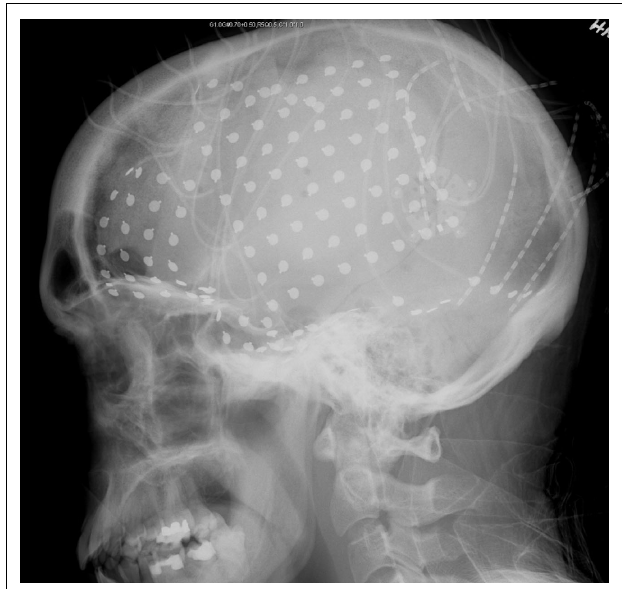
FIGURE 1 | Location of recording